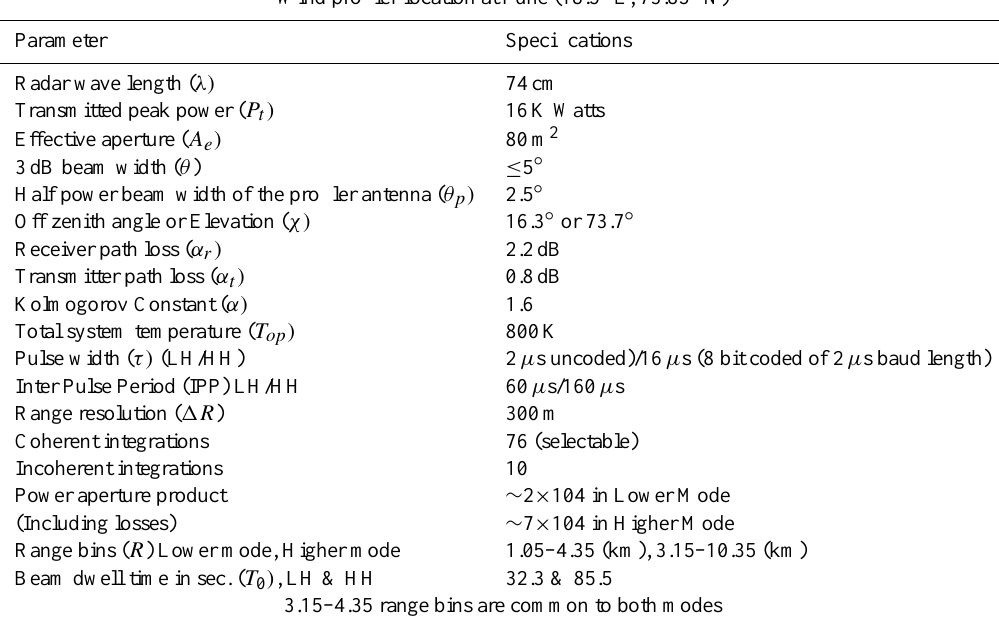
Table 1. Experimental specifications and data processing